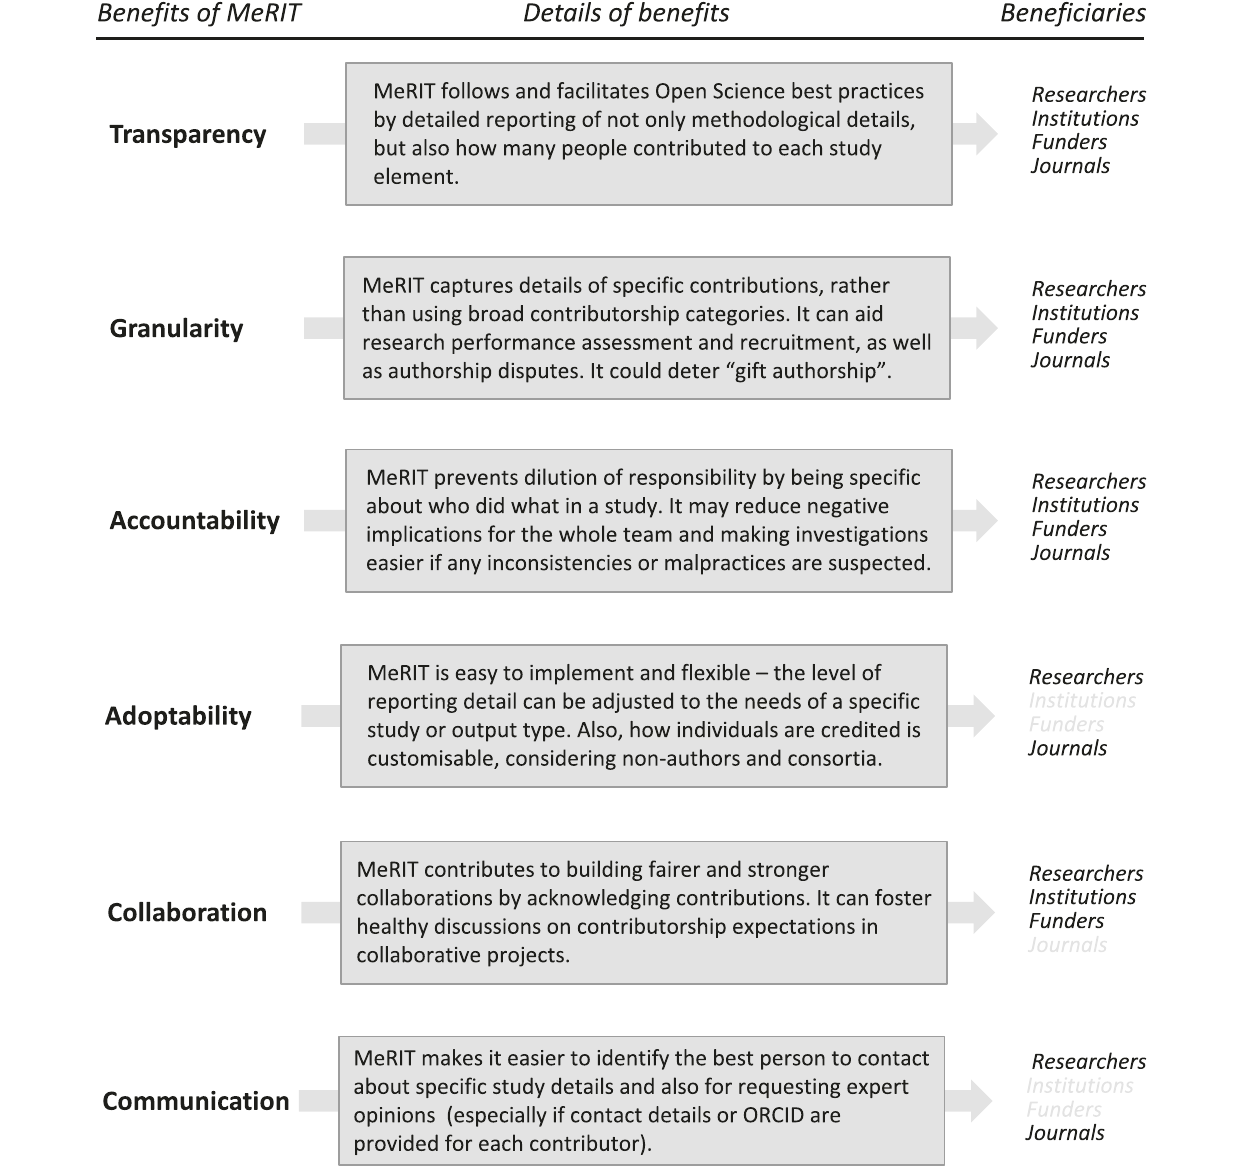
Fig. 2 | MeRIT ’ s bene fi ts. Six bene fi ts of MeRIT, transparency, granularity, accountability, adoptability, collaboration and communication with their bene fi ciaries (stakeholders: researchers, institutions, funders and